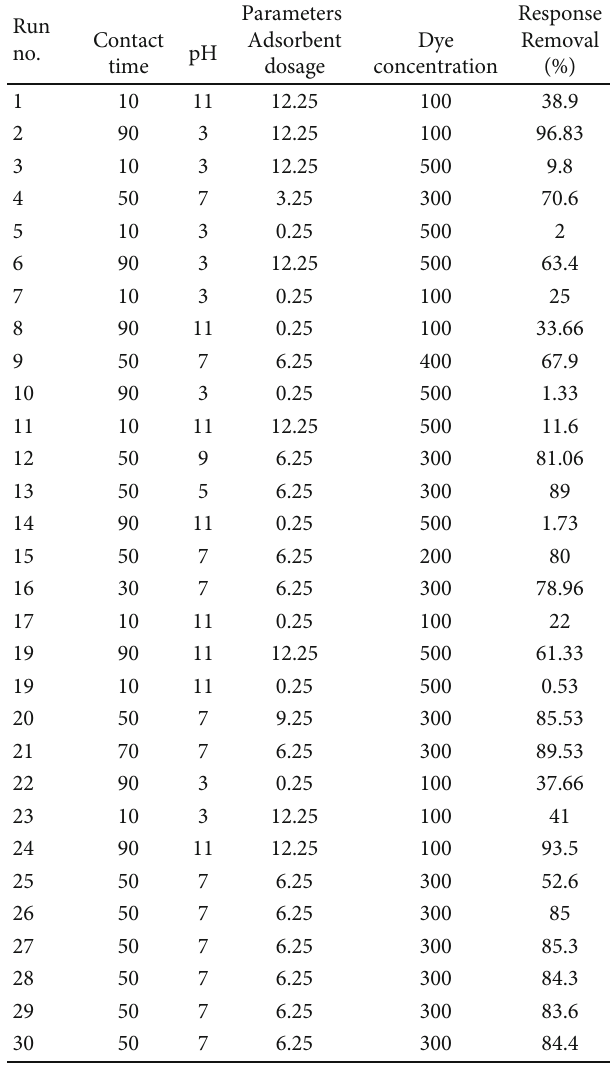
Table 2: Experimental conditions for adsorption process in the presence of prepared